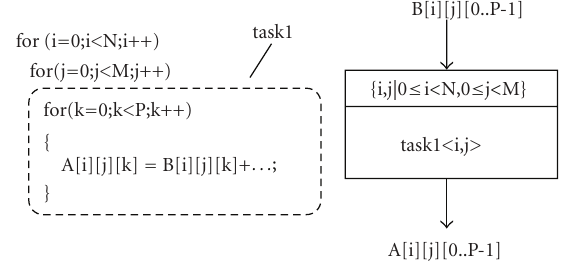
Figure 3: Concurrent task